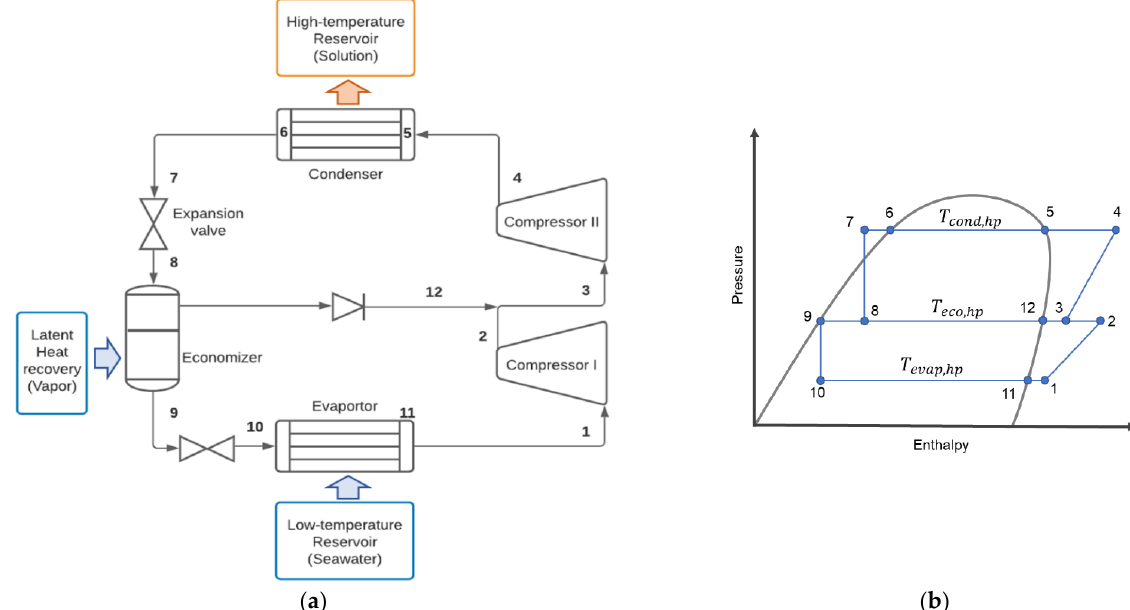
Figure 3. Two-stage HP with an economizer [29] for WavoWater: ( a ) Schematic diagram, ( b ) cycle in P-h diagram.